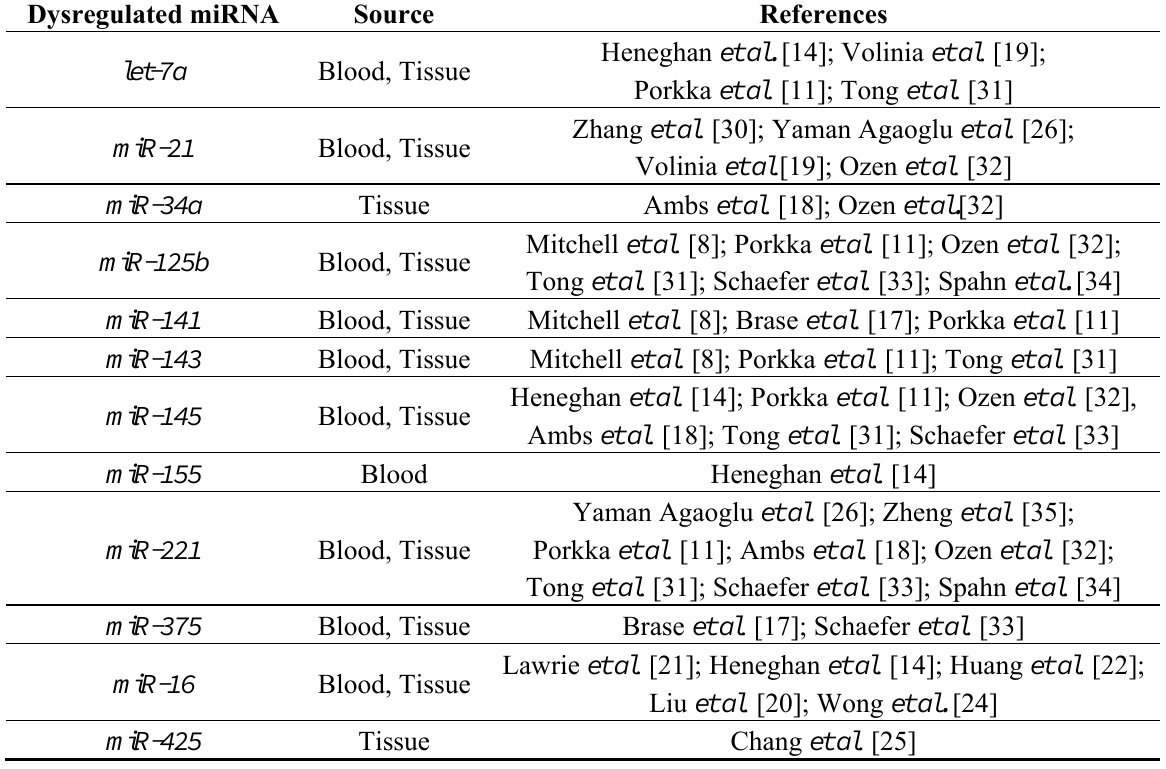
Table 1. The 12 miRNAs selected for the expression profiling in the circulation. Dysregulated